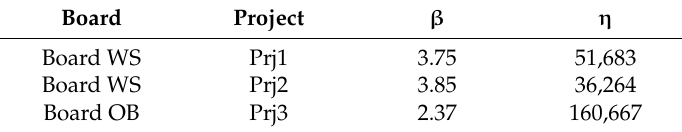
Table 2. Weibull parameters β and η for use-case boards.